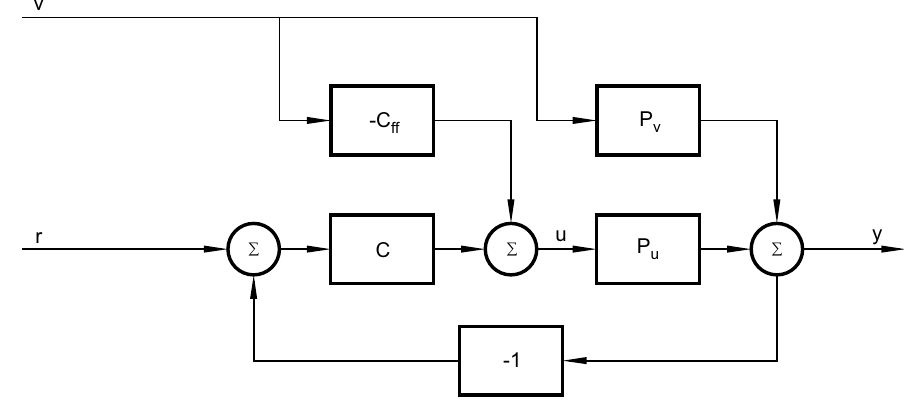
Figure A1. Feedback plus feedforward control